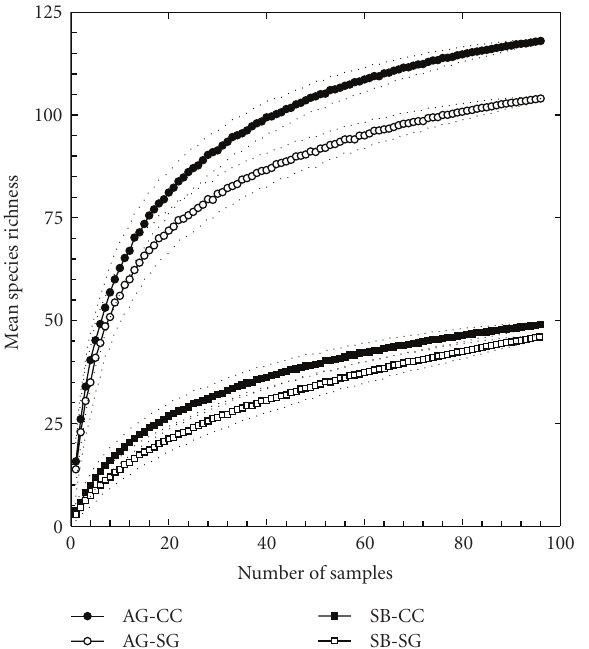
Figure 1: Bootstrap-derived species-area curves ( ± 2 SD; dotted lines) for 96–2.5 m 2 aboveground (AG) and seed bank (SB) samples in revegetating clearcut (CC; ∼ 7 years) and second-growth (SG; ∼ 125 years) forest stands at WWRS, Athens County, Ohio, USA.